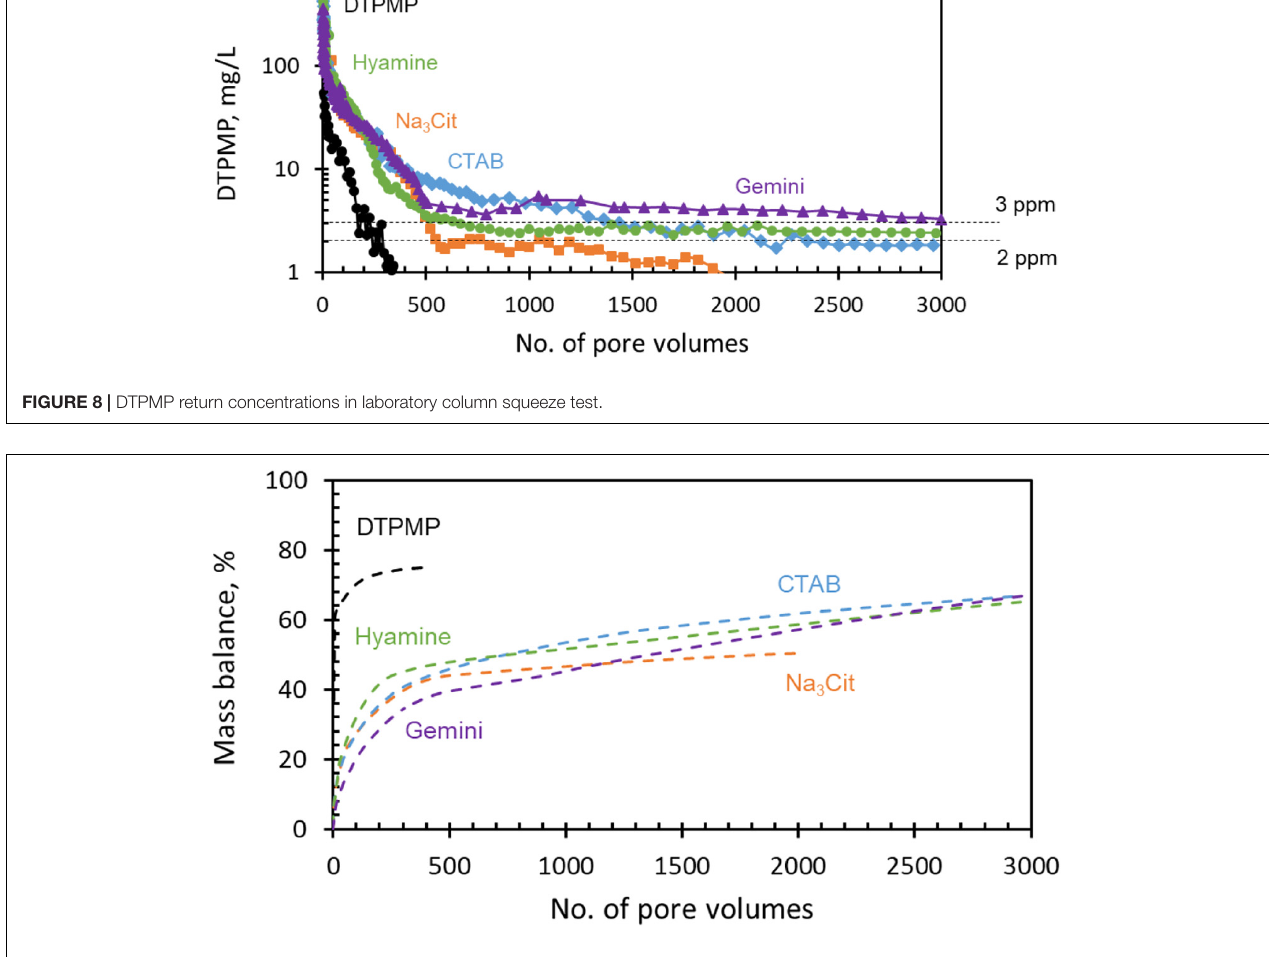
FIGURE 9 | Calculated DTPMP mass balance with